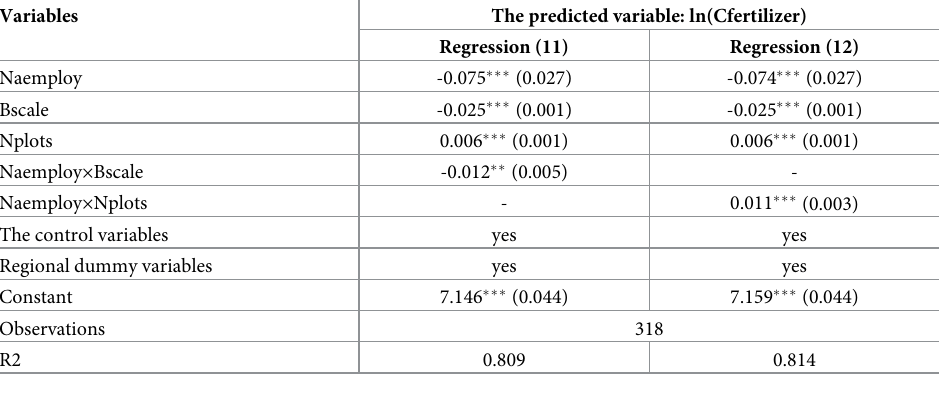
Table 5. Model estimation results of CF application intensity of sample farmers (including interactive